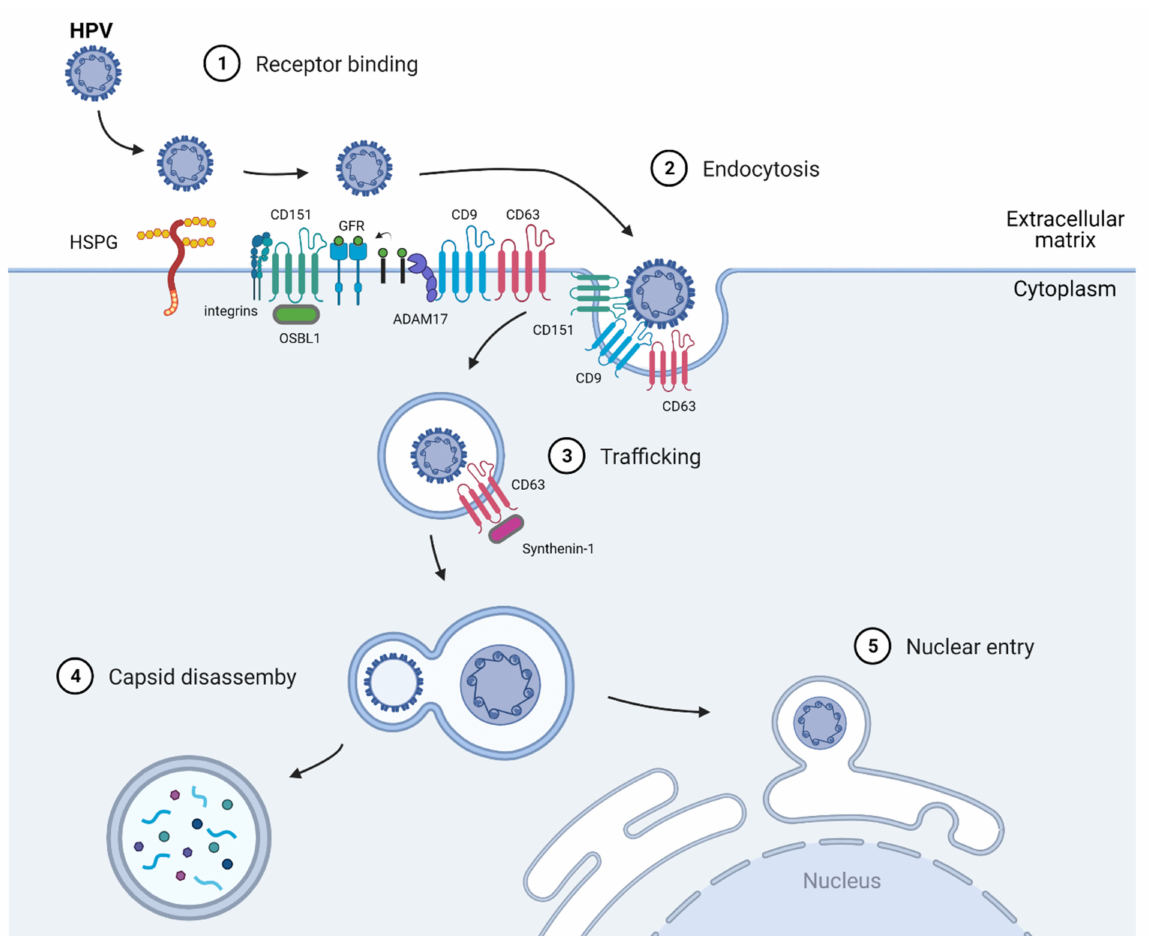
Figure 1. Diagram showing the contribution of tetraspanins in the HPV-1 replication cycle. CD151 and CD9 mediate HPV endocytosis in the secondary binding complex, together with adaptor proteins OBSL-1 and ADAM17, respectively. Mean- while, CD63 and adaptor protein syntenin-1 are involved in the trafficking of the endocytosed HPV virus to multivesicular endosomes. Abbreviations: HPV, human papillomavirus; CD9, cluster of differentiation 9; CD63, cluster of differentiation 63; CD151, cluster of differentiation